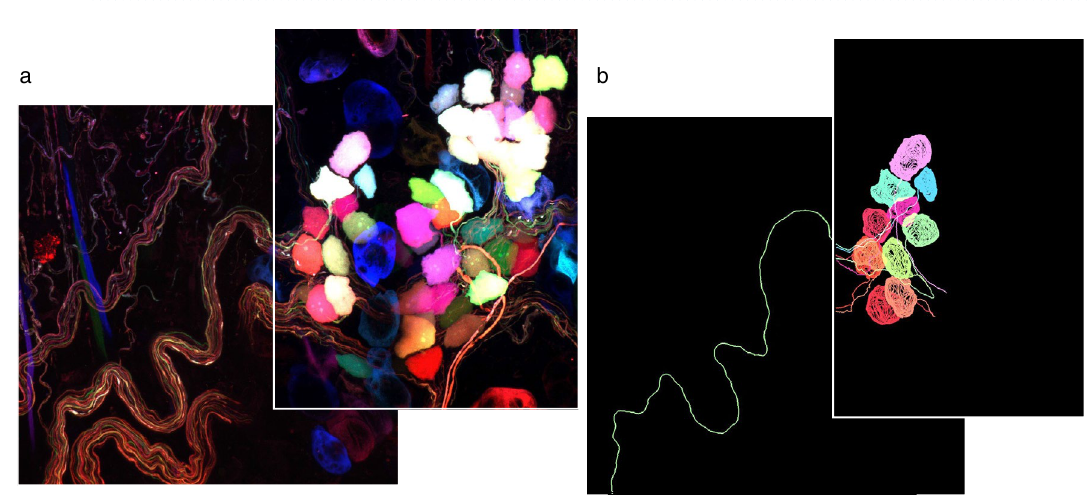
Figure 6. Nerves were traced using nTracer plugin for FIJI. ( a ) Original overlapping images of parasympathetic neurons. ( b ) Traces of select neurons and